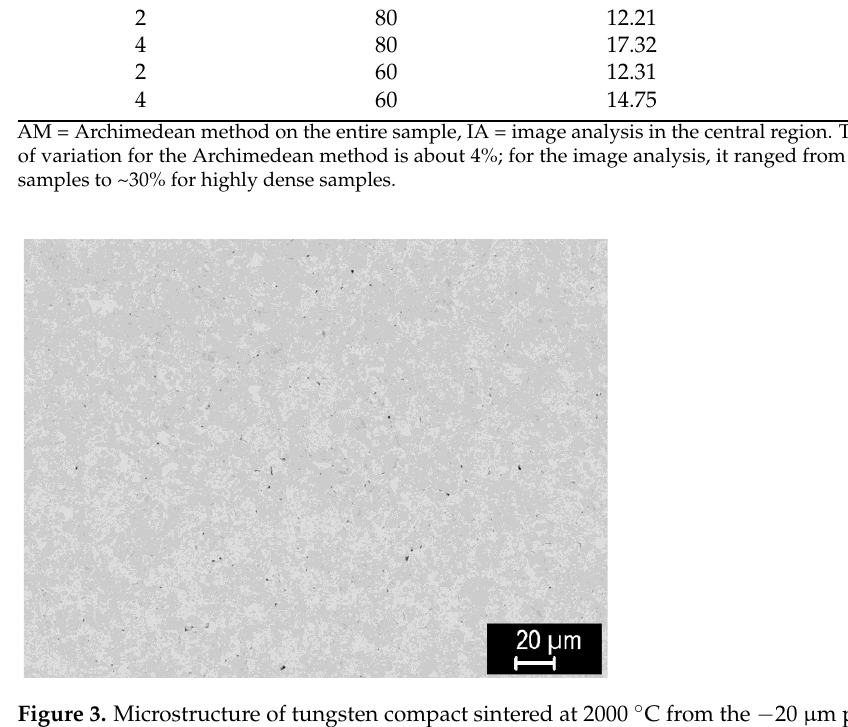
( b ) Figure 4. Fracture surfaces of samples sintered from the 0.4 μ m powder; ( a ) at 1400 °C, ( b ) 1700 °C. Figure 5 shows the dependence of thermal diffusivity on sintering temperature. A trend of increasing diffusivity with increasing sintering temperature is observed, as could be expected by an improved densification. In addition, the following observations can be made. For a moderate variation in temperature — and therefore porosity — diffusivity var- ies only a little. This is in contrast to plasma sprayed coatings, for example, where even a relatively small volume of (largely anisotropic) porosity can reduce the diffusivity signif- icantly [22]. Therefore, from the heat transfer point of view — being important for plasma facing components — a small departure from full sintering is not critical. However, even a small amount of porosity can considerably affect the interaction with plasma, as shown in